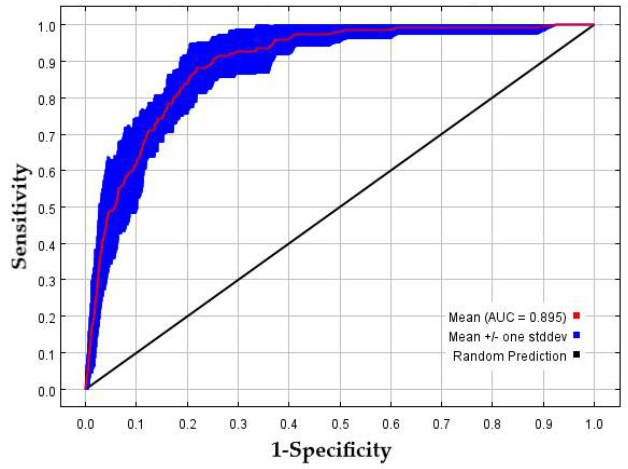
Figure 4. Performances of MaxEnt model under different settings.